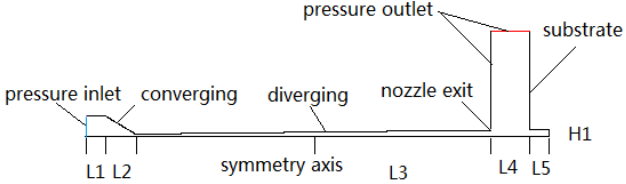
Figure 1. Schematic diagram of axial-symmetrical computational domain and boundary conditions. Table 1. Summary of geometric parameters and working conditions of the cold spray system.